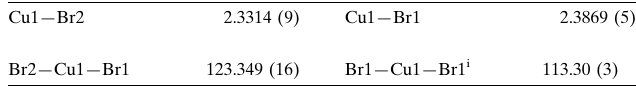
Selected geometric parameters (A˚ , (cid:1)